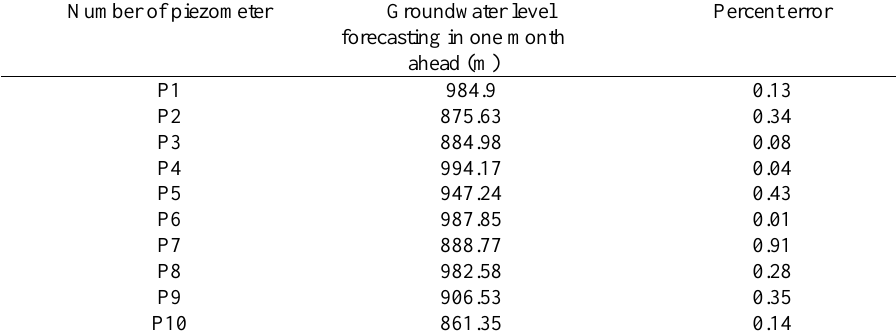
Table 10. Compare groundwater level forecasting with real groundwater level Number of piezometer Groundwater level forecasting in one